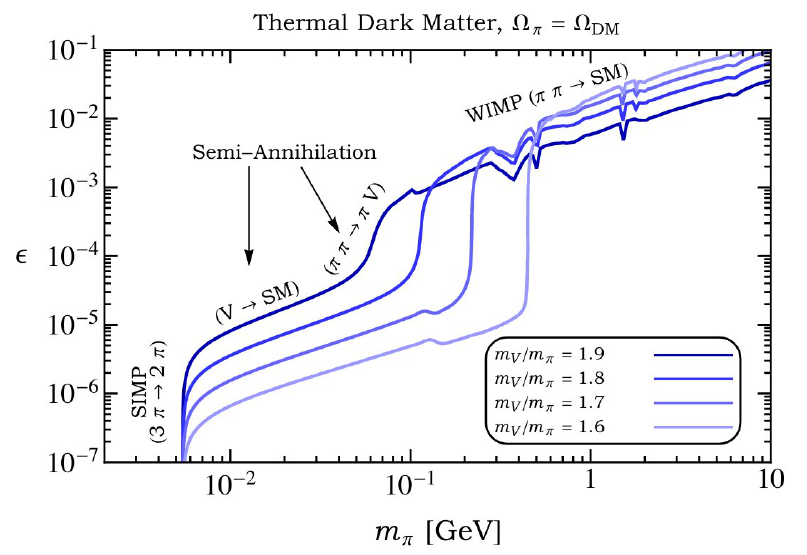
Figure 16: Required value of kinetic mixing versus m π (cid:48) to obtained the observed DM density, taking account of vector meson effects, from Ref. [ 107 ]